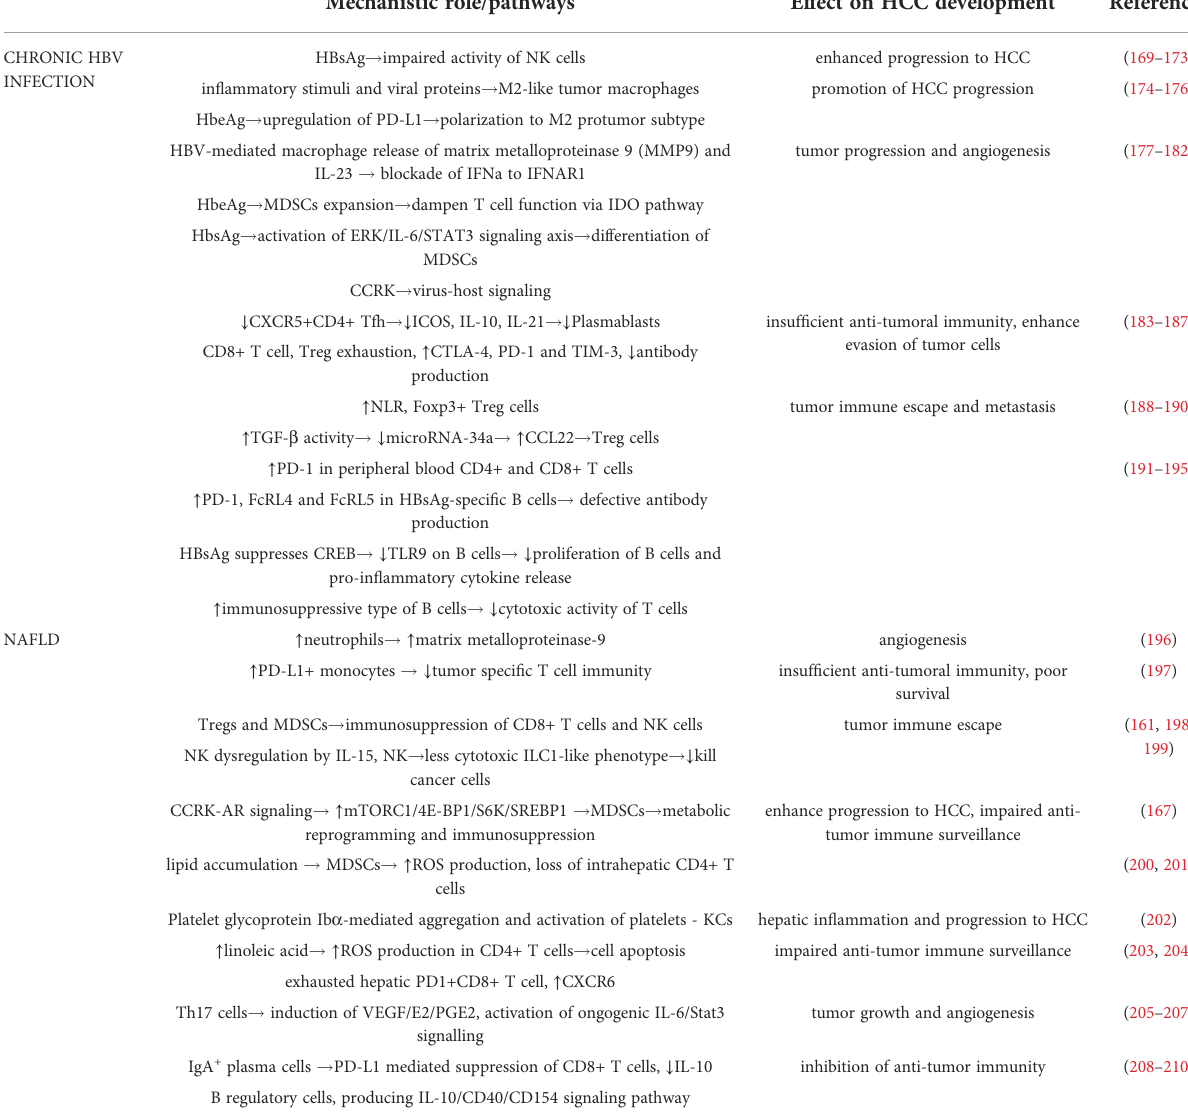
TABLE 2 Effects of chronic HBV infection and NAFLD on HCC